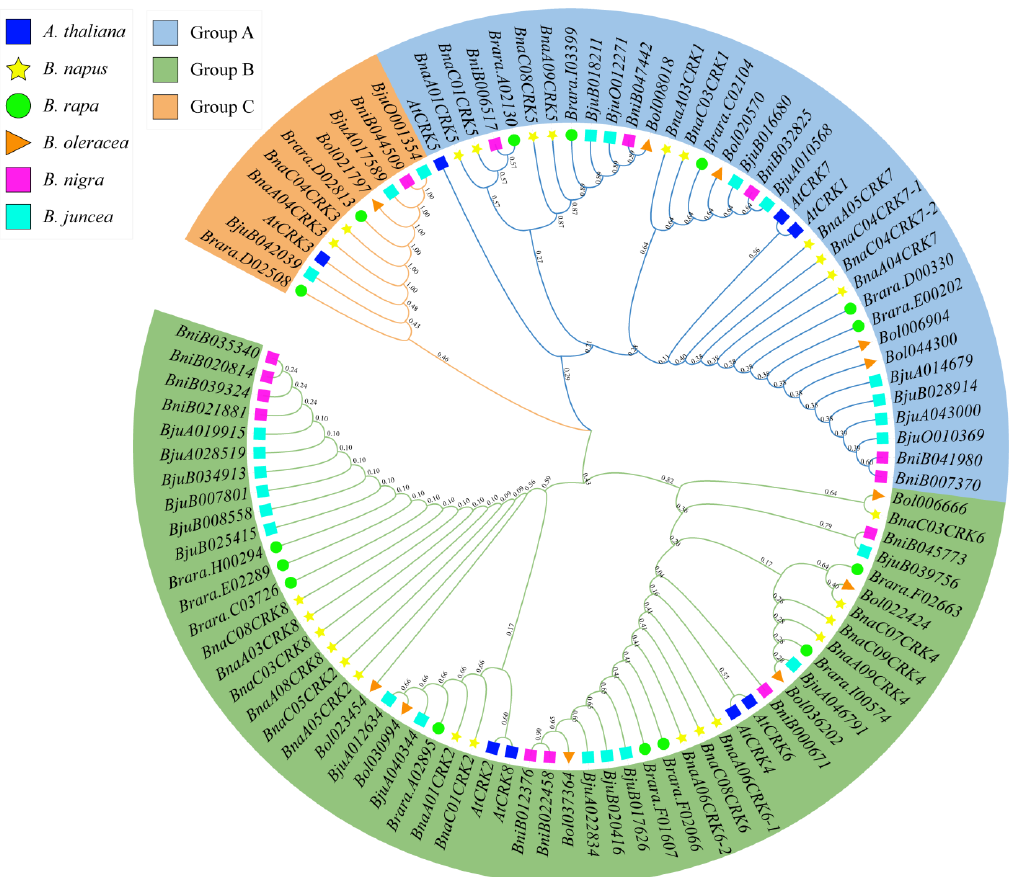
Figure 1. Phylogenetic tree analysis of CRK genes from A. thaliana ( At ), B. napus ( Bna ), B. oleracea ( Bol ), B. rapa ( Bra ), B. juncea ( Bju ), and B. nigra ( Bni ). The CRK genes are categorized into three groups (A, B, and C) and indicated as different colors.